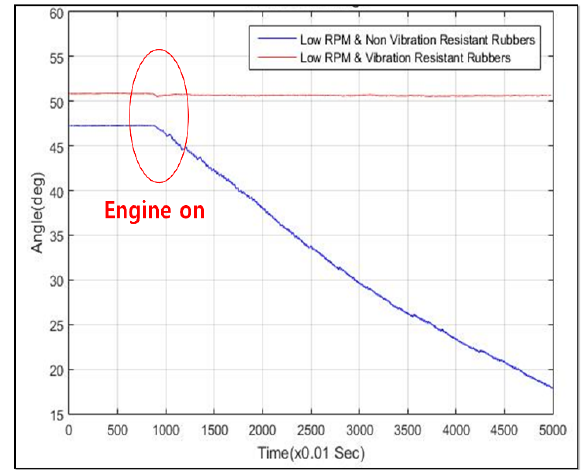
Figure 10. The importance of the anti-vibration system: drift occurred when anti-vibration rubber was not